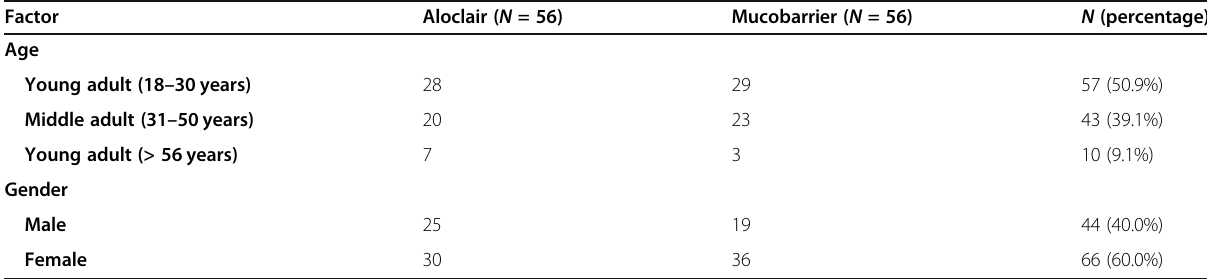
Table 1 Demographic factors of